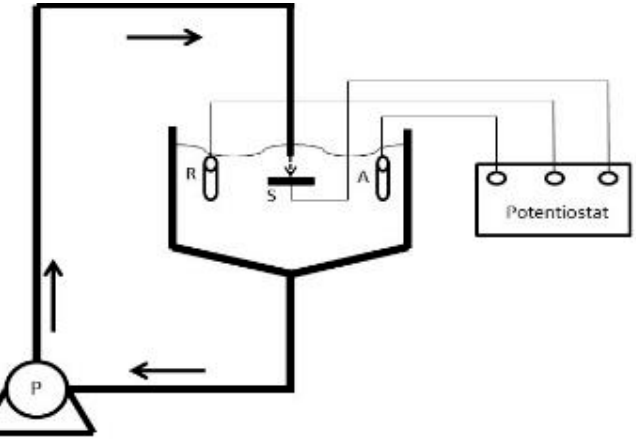
Figure 1. Schematic representation of recirculating, submerged-impingement, slurry-jet test rig.